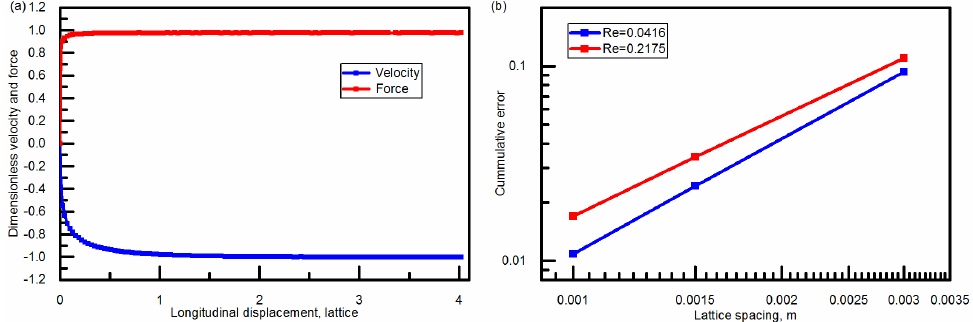
Figure 5. ( a ) Normalized velocity and Force for a spherical particle settling between infinite walls. ( b ) Cumulative computational error under different Reynold numbers with different lattice spacing.